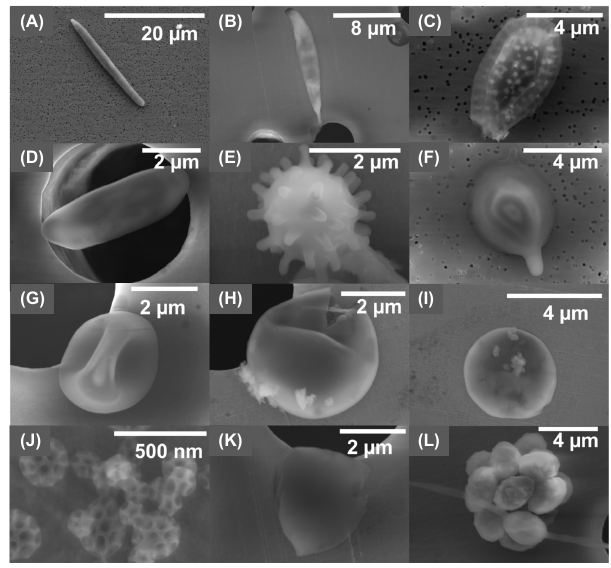
Fig. 7. Scanning electron micrographs showing example PBAP im- ages from AMAZE-08 campaign. Scale bar shown in each